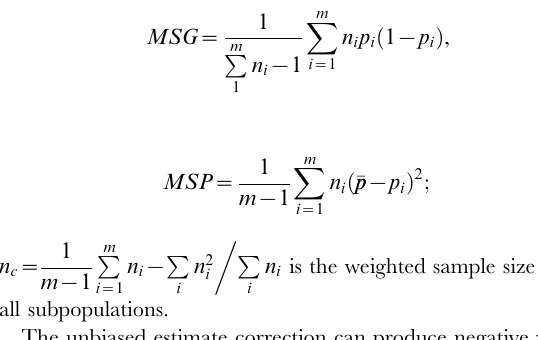
Figure S3 Phenotypic distribution of amylose content in different subpopulations as defined in Supplemental Table S1.